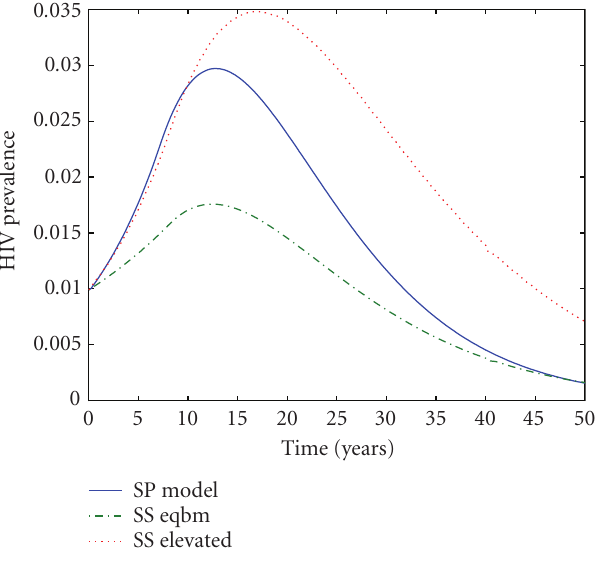
Figure 4.1 . Single-stage (SS) and staged progression (SP) HIV prevalence projections for a low- prevalence setting, C 0 =